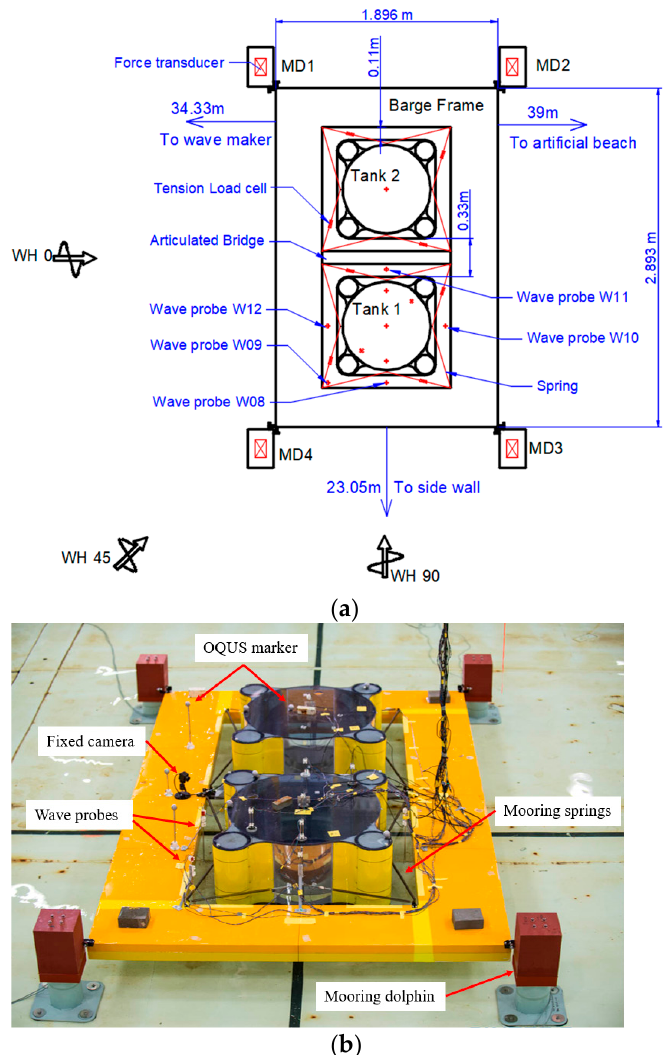
Figure 5. ( a ) Layout of model tests on the subsystem of floating hydrocarbon storage facility; ( b ) setup of physical models in the basin [22].